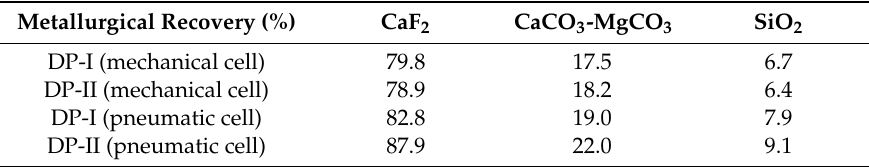
Table 3. Metallurgical recoveries for DP-I and DP-II at the 100 g / t dose.